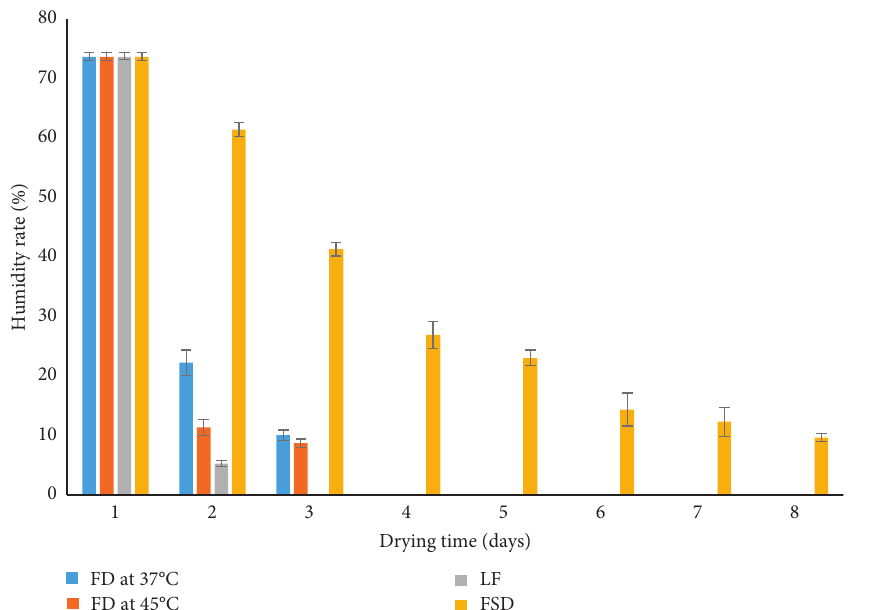
Figure 2: Variation in the humidity rate of traditional mashed cassava ferment during drying. FD at 37 ° C: ferment dried at 37 ° C; FD at 45 ° C: ferment dried at 45 ° C; FSD: ferment sun-dried; LF: lyophilized ferment. Table 1: Microbial loads of the different ferments before and after drying. Microbial load